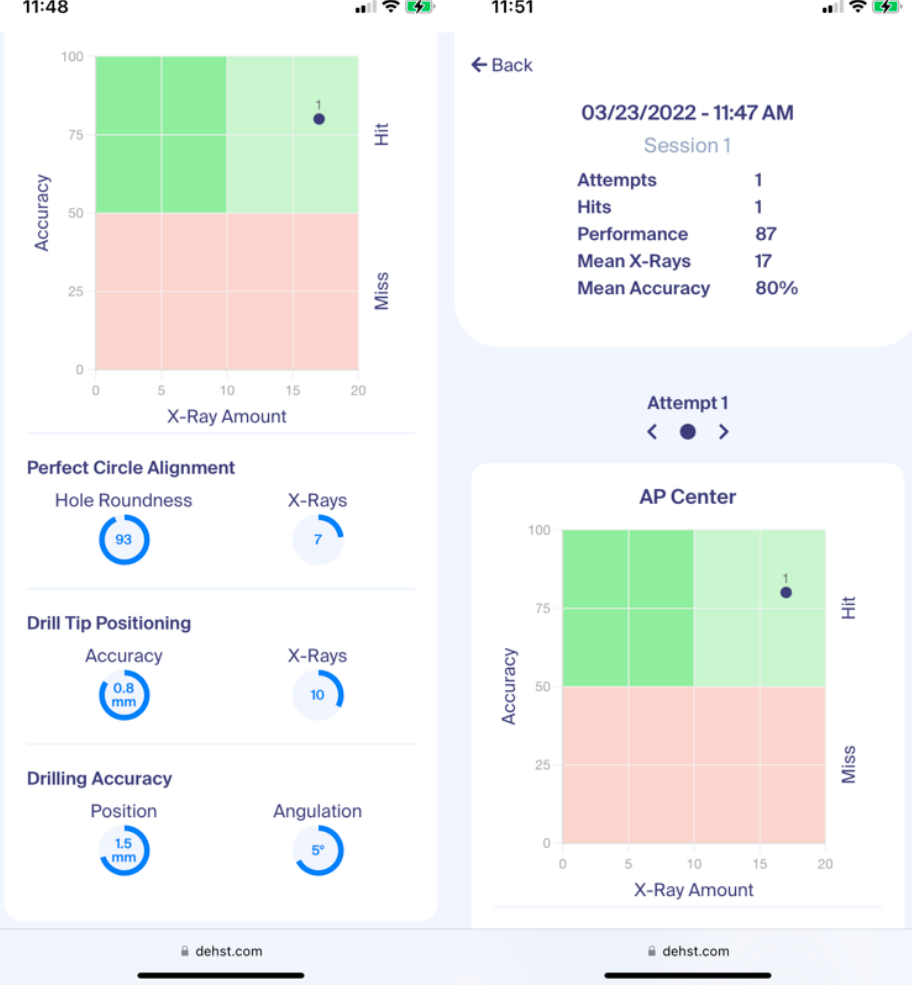
Figure 3. DEHST web application for data collection, analytics and training assessment.